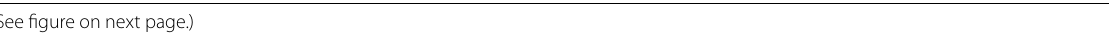
(See figure on next page.) Fig. 8 a Map view of the nodes of the fault grid, with 15 nodes in the horizontal direction and 6 nodes in the vertical direction. Epicenter of EV1 ( yel- low star ) and the 24-h aftershocks ( M JMA ≥ 3 ) ( red circles ) are also shown. b Distribution of cross-correlation. The time attached to each figure denotes the lag time ( τ ) plus the half width of the source time function (3 s). The JMA hypocenter ( ) and the point of maximum averaged cross-correlation + of 0.53 (cross) are shown in the top figure for 3 s (i.e., τ 0 s) and the middle figure for 7 s ( τ 4 s). c Examples of normalized velocity waveforms = = (Norm.Vel.). Synthetics correspond to the “grand” maximum value of cross-correlation: That is, a time of 7 s (lag time τ 4 s) and the grid point where = range 25.5 km and depth 15.1 km are used to generate the = =